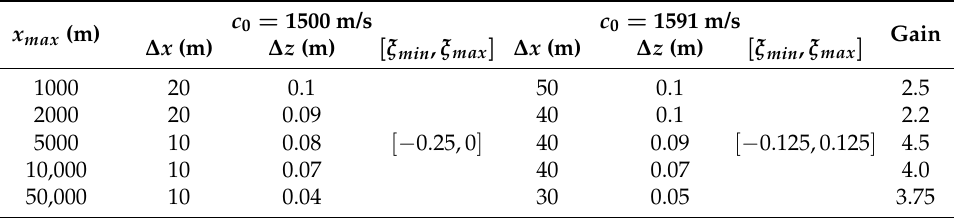
Table 1. Optimal values of the cell sizes, ε = 10 − 3 , θ max = 30 ◦ , f = 500 Hz, rational approximation order is [ 7/8 ] .